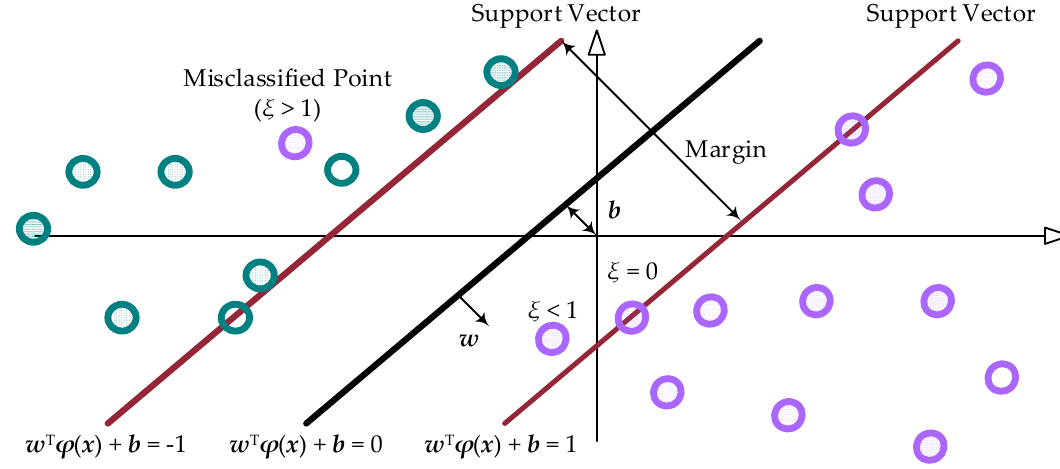
Figure 8. Principle of support vector machine operation.